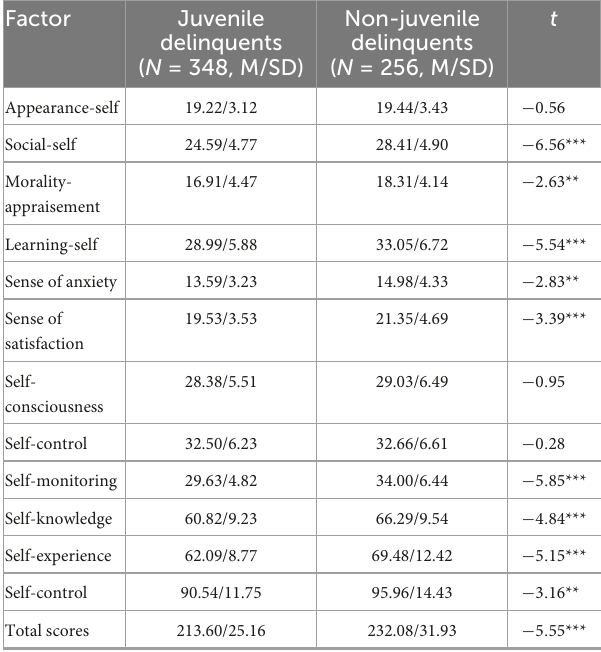
TABLE 2 Comparison of the factors of self-consciousness between juvenile delinquents and non-delinquent